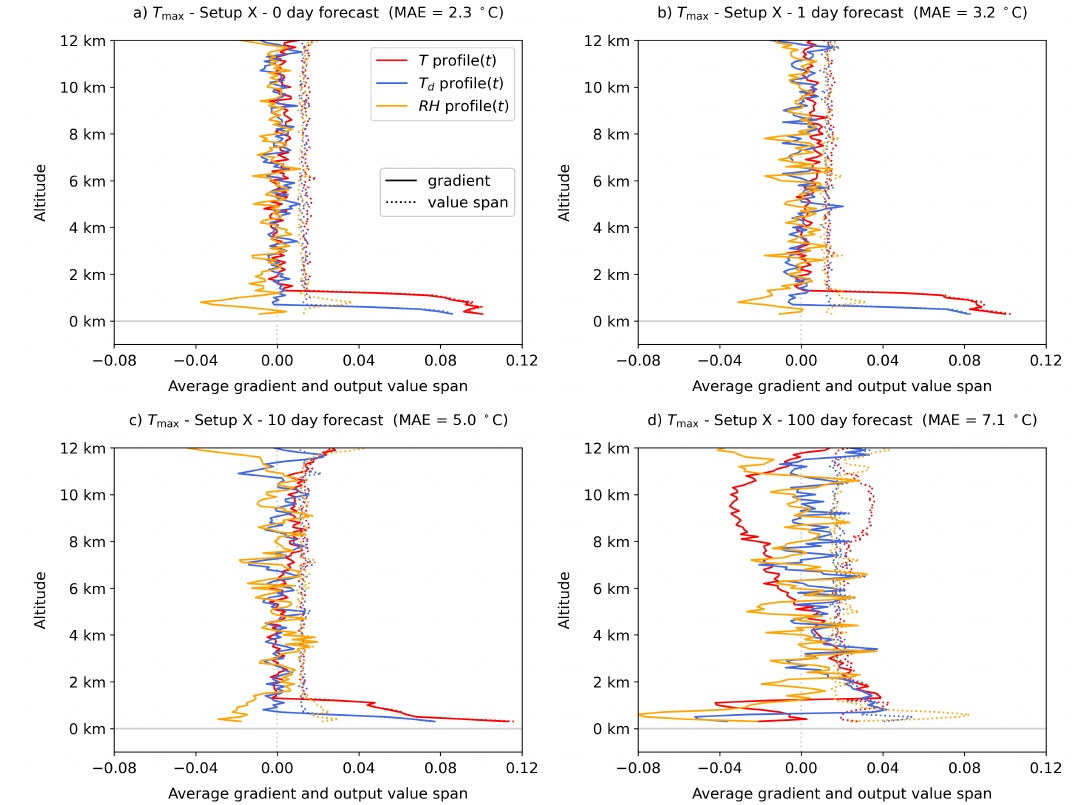
Figure 6. The results of the XAI analysis for forecasts of T max by NN Setup X. The subfigures show the analysis for different forecast lead times: ( a ) 0 day; ( b ) 1 day; ( c ) 10 day; ( d ) 100 day. The average input gradient is shown by solid lines and the average output value span by dotted